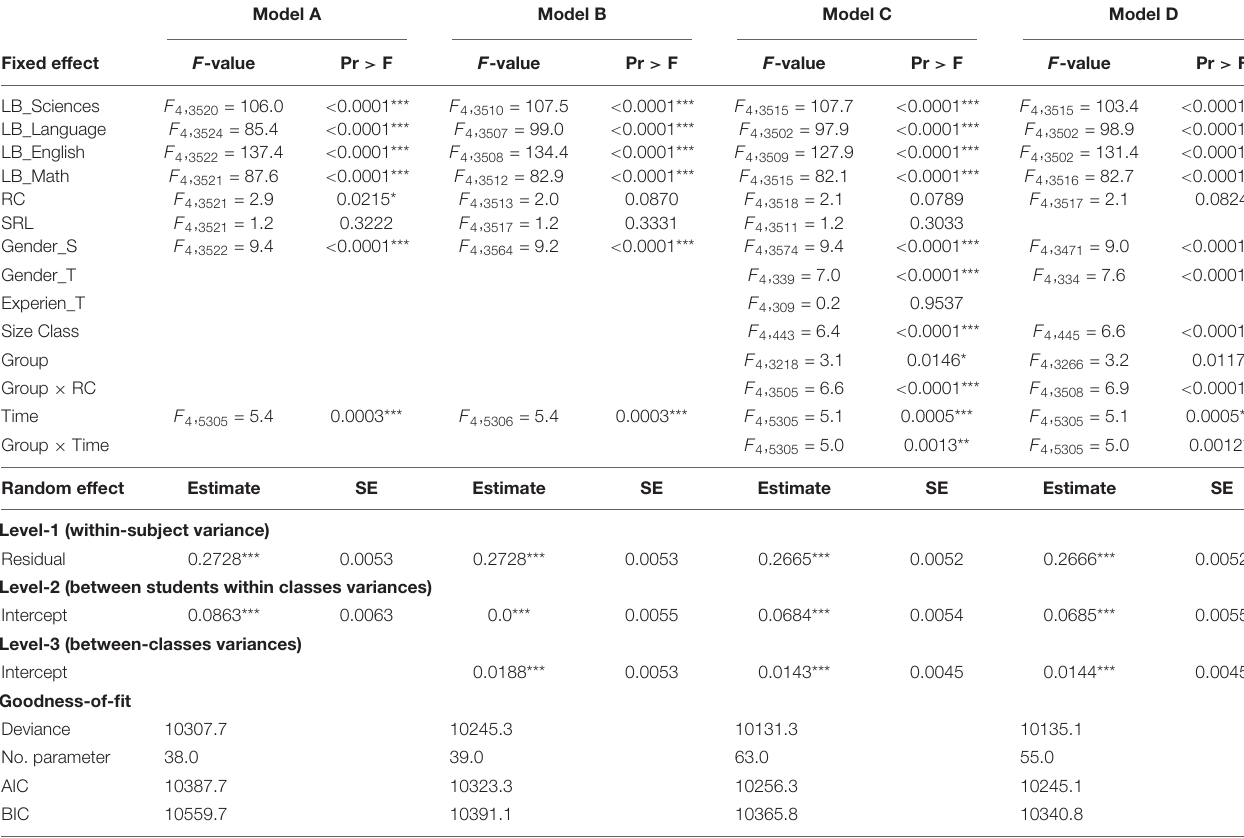
TABLE 1 | Results of fitting four multivariate mixed-effects regression model analyses. Model A Model B Model